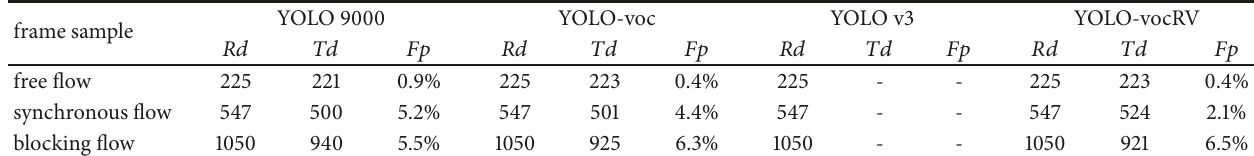
Table 2: Statistics of different model results for synchronous flow sample training.